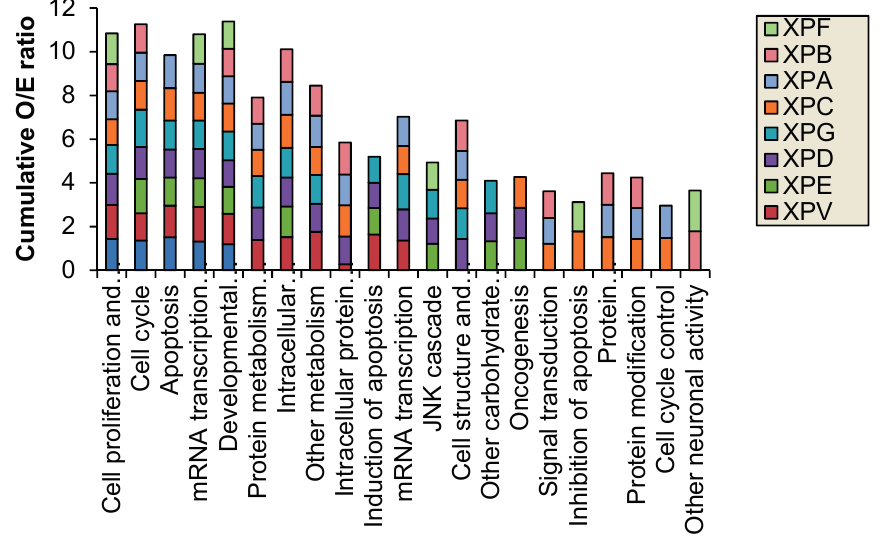
Figure 3. Biological processes with significantly ( p < 0.05) different observed (O) vs. expected (E) ratio of transcripts with altered expression after 2 J/m 2 UVC-light treatment. XP-B and XP-F were the only XP complementation groups to have altered neuronal